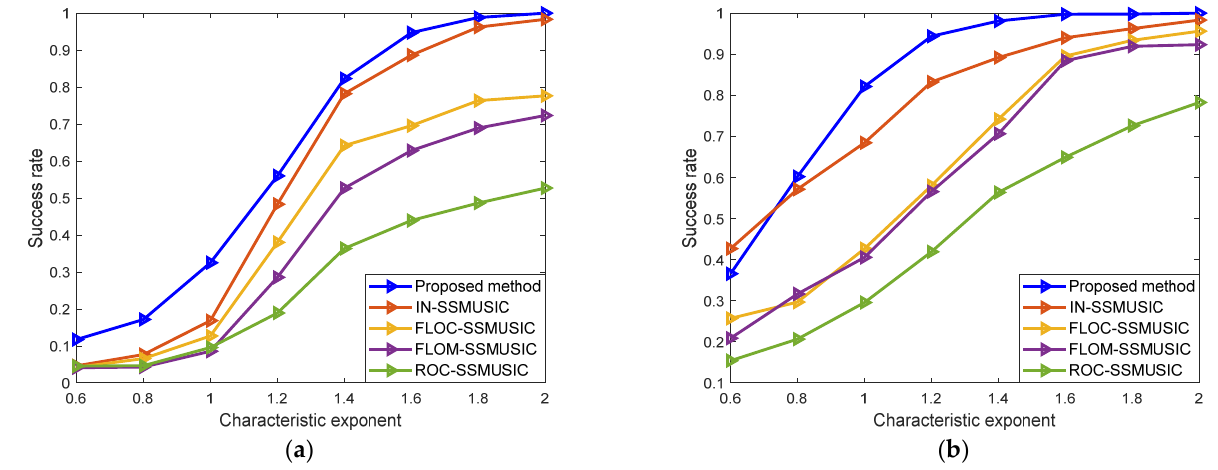
Figure 7. Influence of characteristic exponent on algorithm performance: ( a ) GSNR = 10 dB; ( b ) GSNR = 20 dB.